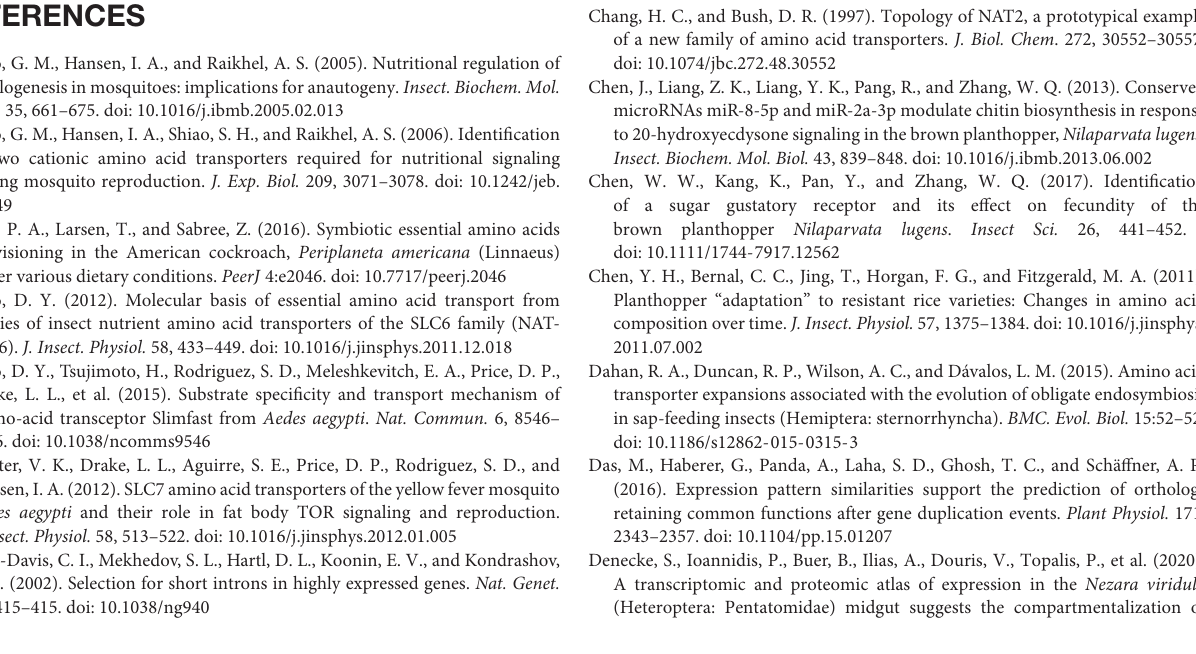
Supplementary Figure 2 | The sequence logo of 10 conserved motifs predicted in BPH APC transporter proteins. MEME Suite 5.5.3 was used to analyze the conservation of amino acid residues contained in the predicted conserved motifs of BPH APC transporter proteins. Supplementary Figure 3 | The expression level of NlAPC09 in the ovaries of BPHs at 24, 48, and 72 h post-RNAi. β -actin gene was used to normalize the gene expression of NlAPC09 in BPH. The mRNA level of NlAPC09 in the ds GFP -treated BPHs was set to 1. Single asterisks ( P < 0.05) and double asterisks ( P < 0.01) indicate significant differences in mRNA level of NlAPC09 between ds GFP - and ds NlAPC09 -injected groups. Supplementary Table 1 | The primers used in this study. Supplementary Table 2 | The amino acid sequence of APC transporter genes identified in four hemipteran insects. Supplementary Table 3 | TPM values of APC transporter genes of BPH at different developmental stages. Stage-specific gene expression level of APC transporters was calculated using Kallisto v0.46.1 based on a series of RNA-seq data downloaded from NCBI database. A total of 15 different developmental stages were evaluated in this